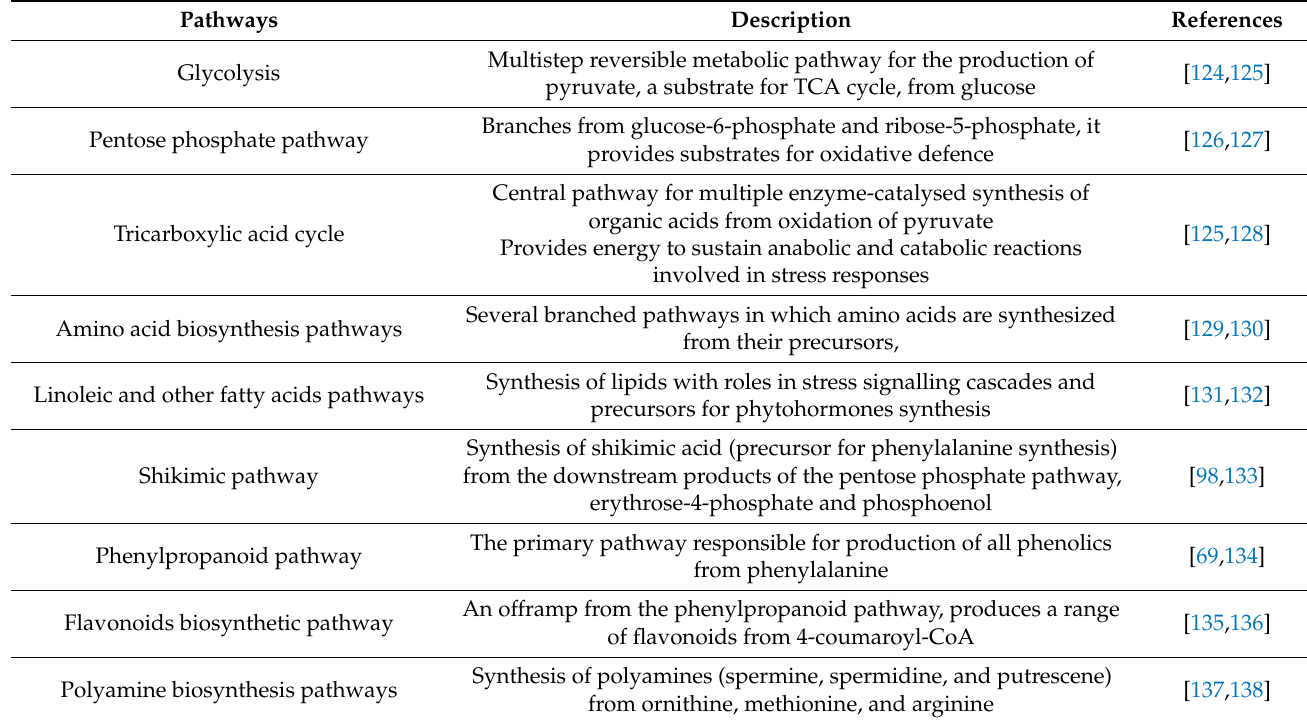
Table 1. The primary and secondary metabolism pathways involved in plant responses to salinity stress.